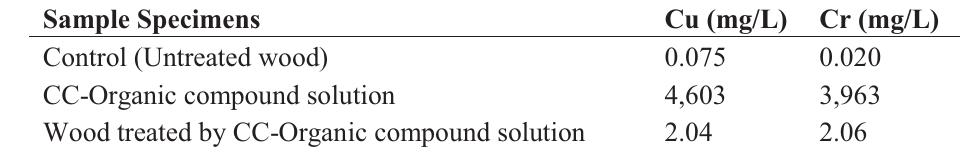
Table 5. Inorganic compound (copper chromium complex) of treated wood specimens.